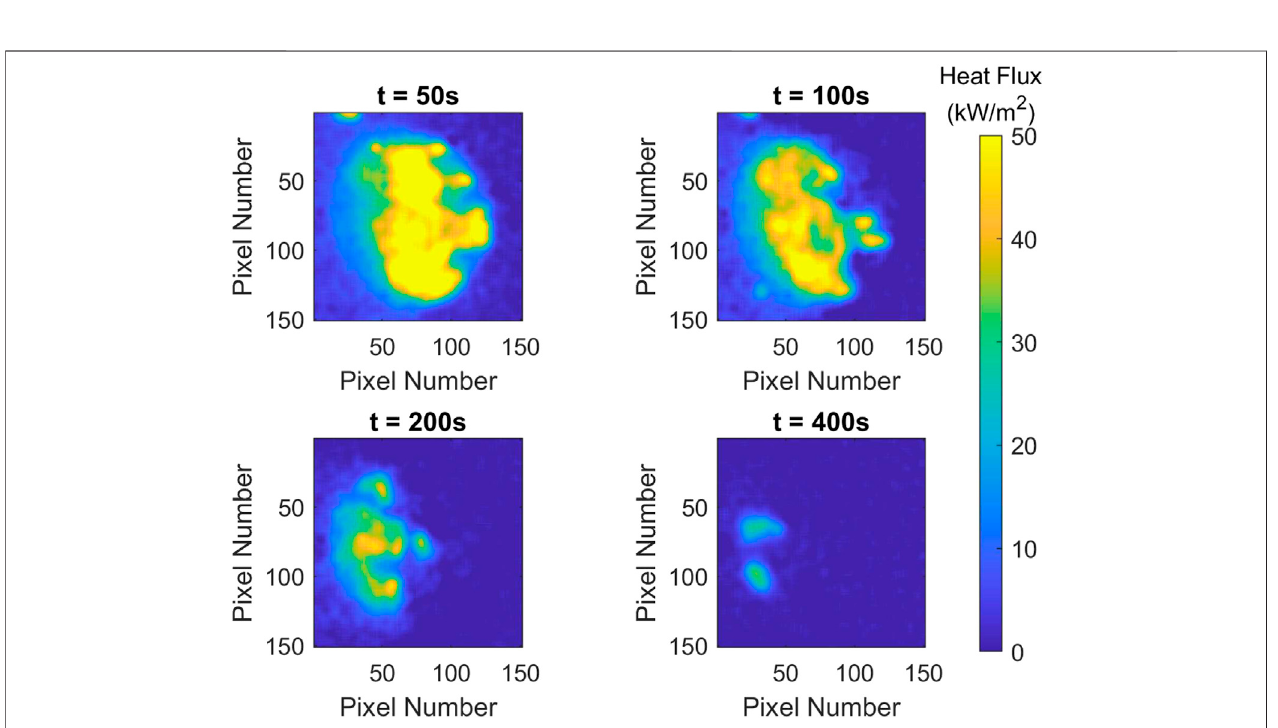
FIGURE 14 | Heat fl ux distributions for test FF14 at different times. Firebrands: D (cid:2) 4.75 mm, L (cid:2) 50.0 mm, and AR (cid:2) 10.5; Pile mass of m (cid:2) 3.0 g; Wind speed: U (cid:2) 2.0 m/s.